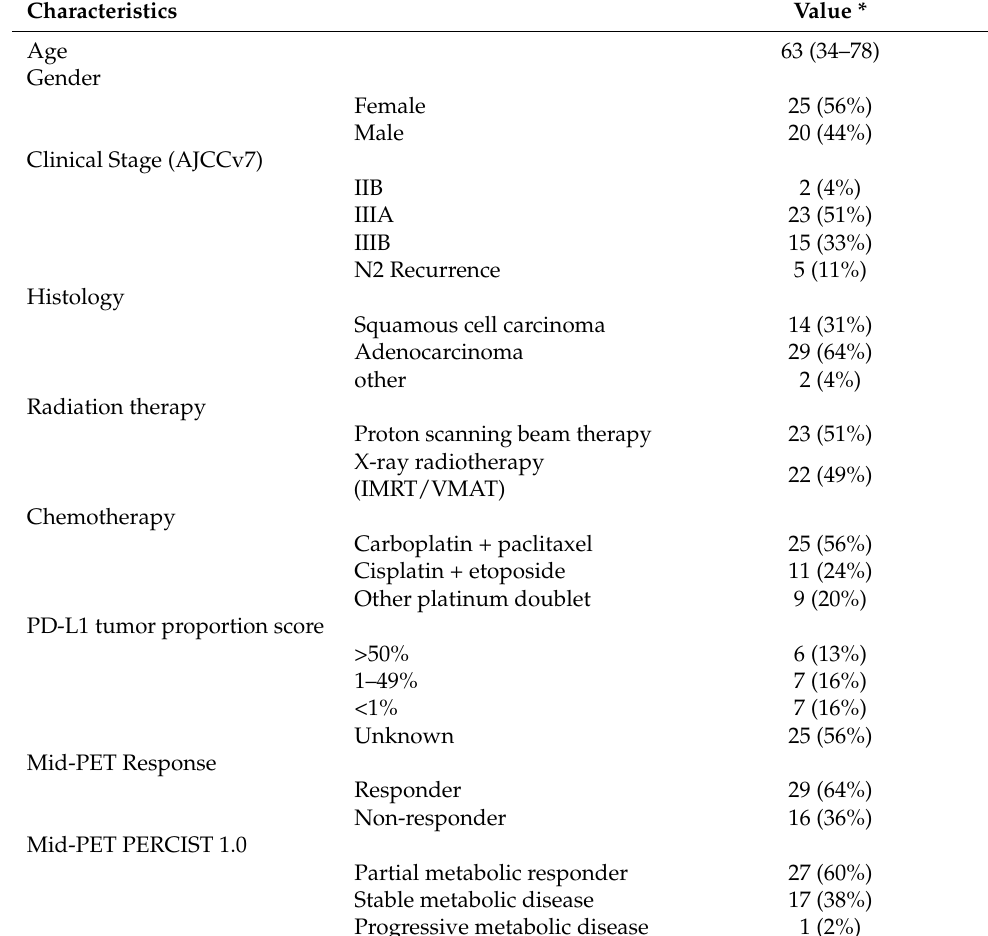
Table 1. Demographic and clinical information of the participants in the FLARE-RT clinical